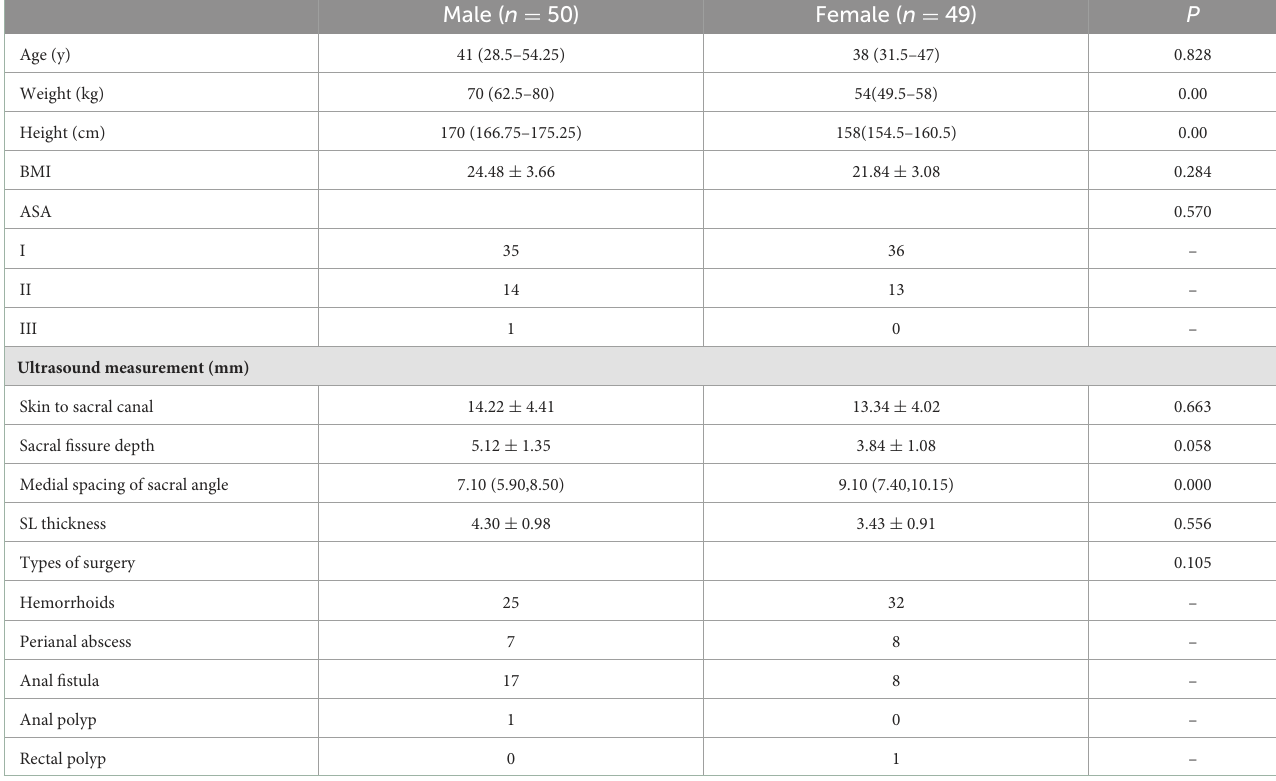
TABLE 1 Characteristics of patients.